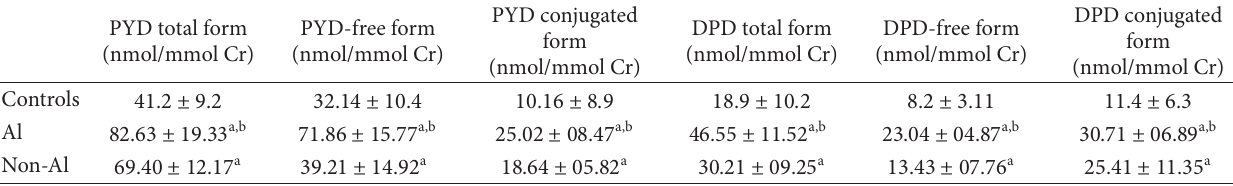
Table 3: Bone resorption markers PYD and DPD